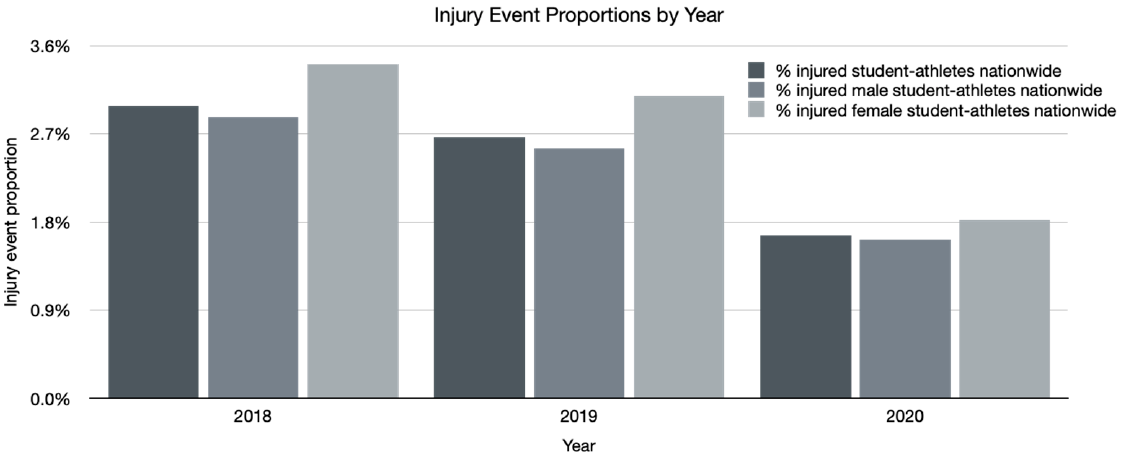
Figure 4. Injury event proportions by year. Injury event proportions decreased for both males and females from 2018 to 2020.